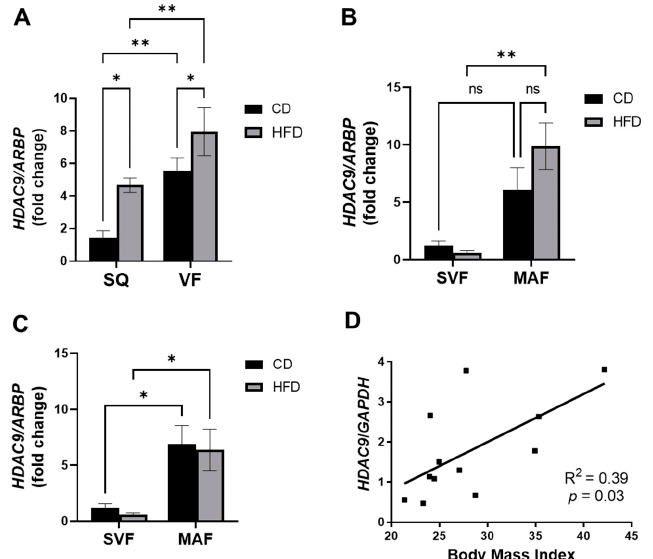
Figure 1. HDAC9 expression is increased in adipose tissue under obese-conditions. ( A ) HDAC9 mRNA expression in SQ and VF from CD- and HFD-fed female WT mice. HDAC9 mRNA expression in SVF and MAF from SQ ( B ) and VF ( C ) of female CD- and HFD-fed WT mice ( n = 5–6). ( D ) HDAC9 protein expression in human SQ correlated with body mass index ( n = 12). Data represent mean ± SEM. * p < 0.05, ** p < 0.01, ns, not significant. SQ, subcutaneous adipose tissue; VF, visceral adipose tissue; CD, chow diet; HFD, high fat diet; SVF, stromovascular fraction; MAF, mature adipocyte fraction.